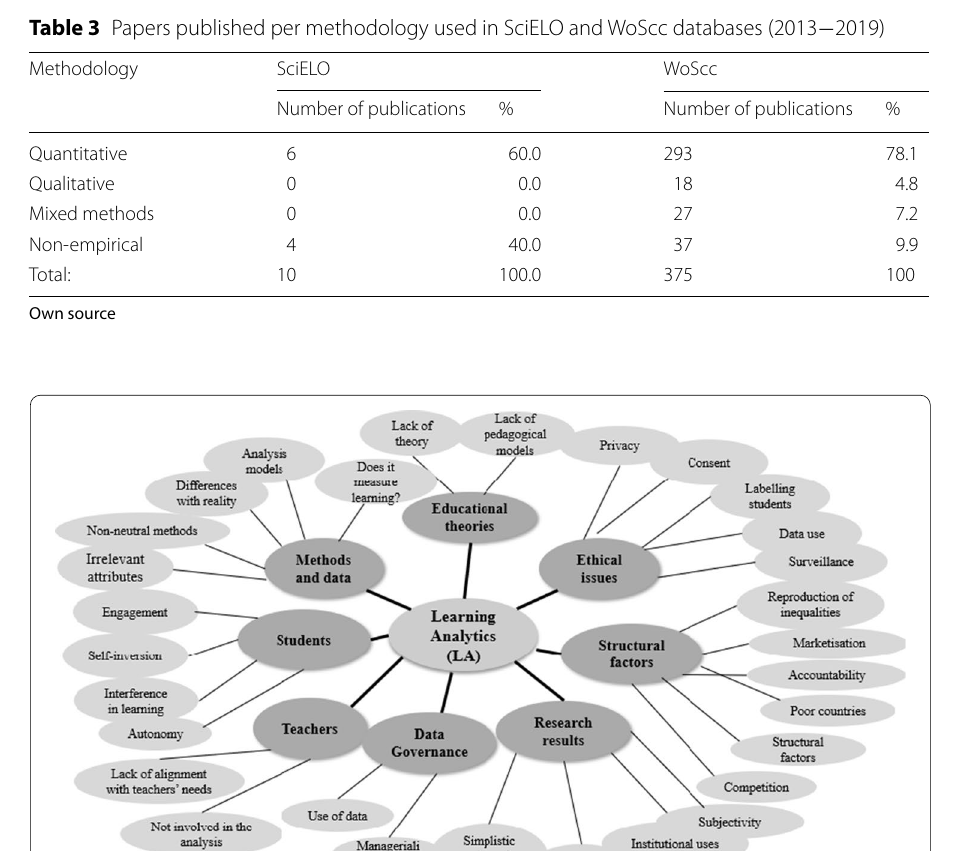
Table 3 Papers published per methodology used in SciELO and WoScc databases (2013